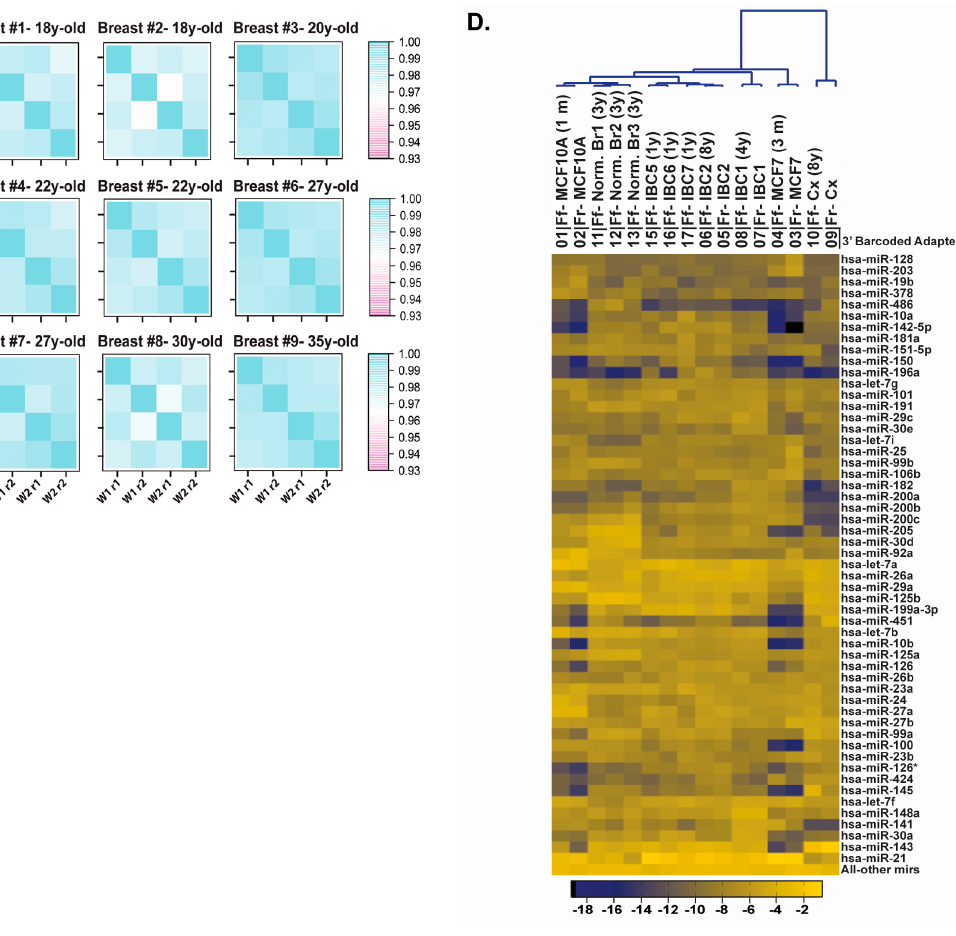
Figure 3. Evaluation of the reproducibility of the barcoded cDNA library preparation procedure. ( A ) Unsupervised clustering of miRNA expression from two-year-old breast cancer #3, three-year-old breast cancer #4 and the 35-year-old benign breast tissue specimens (200, 100 and 50 ng total RNA in duplicates for each specimen); ( B ) Correlation matrices displaying reproducibility between repeats and between different RNA amounts for all three specimens; ( C ) Correlation matrices displaying reproducibility for nine FFPE RNA benign breast tissue specimens. Duplicate measures were performed within the same library (Repeat 1 (r1) and repeat 2 (r2) and between libraries (Lib#1 and Lib#2) prepared at week 1 (w1) and week 2 (w2)) for 18-, 20-, 22-, 27-, 30-, 35-year-old tissues; ( D ) Unsupervised clustering of miRNA expression data from five pairs of matched fresh or frozen and FFPE specimens and six FFPE specimens. The matched pairs include fresh and one-month-old MCF10A FFPE RNA, fresh and three-month old MCF7 FFPE RNA, frozen and four-year-old invasive breast Tumor 1 (IBC1) FFPE RNA, frozen and eight-year-old invasive breast Tumor 2 (IBC2) FFPE RNA, frozen and eight-year-old normal cervix FFPE RNA. The FFPE specimens include three distinct three-year-old normal breast FFPE RNAs (from three different individuals; Formalin-fixed normal breast Ff-Norm-Br#1, #2, and #3) and three distinct one-year-old invasive breast cancer FFPE specimens from three different individuals (Formalin-fixed Invasive Breast Cancer Ff-IBC#3, #4, and #5). The top 75% miRNAs detected by sequencing are represented.